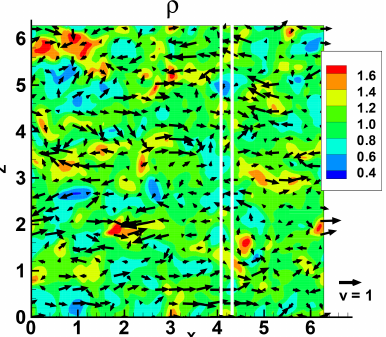
Figure 1. Density distribution (color) and in-plane velocities (ar- rows) in the plane y = 3 . 14 at t = 0 . 71. As a reference, an arrow is drawn to denote a velocity of 1 dimensionless unit. Between the white lines is the slice used in analyses of the slow wave case